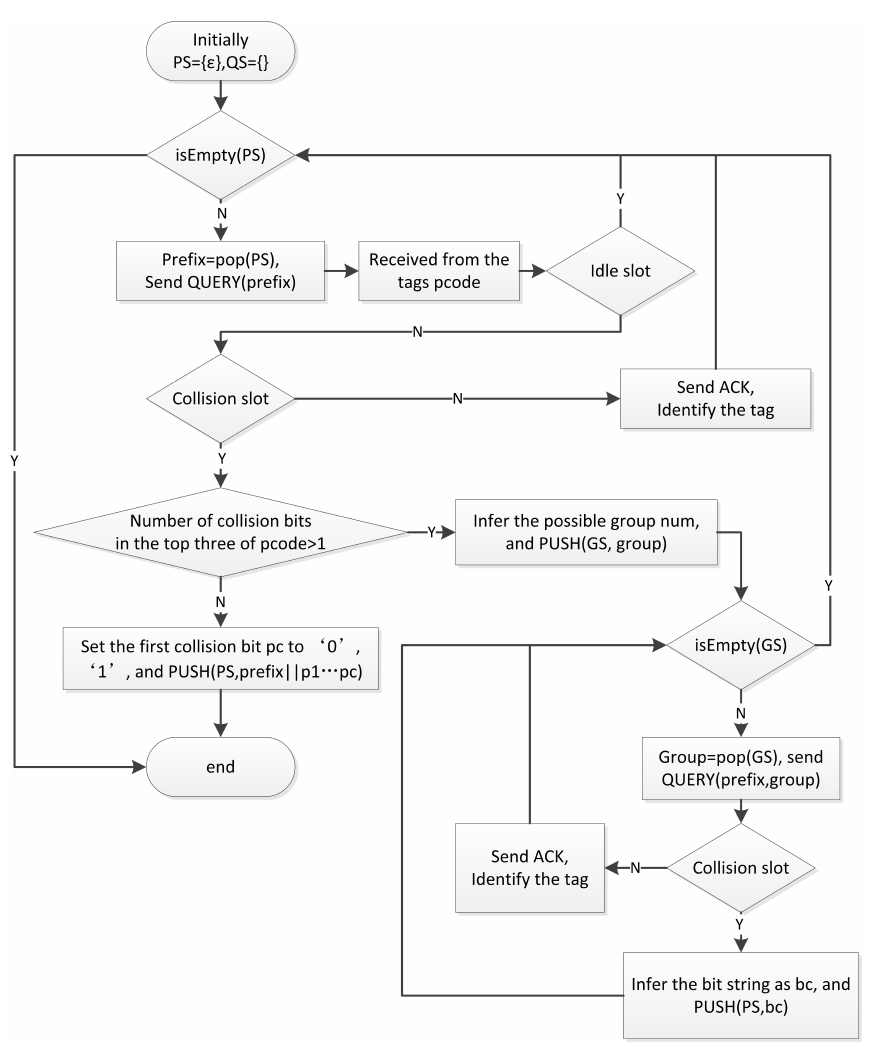
Figure 2. The flow chart of